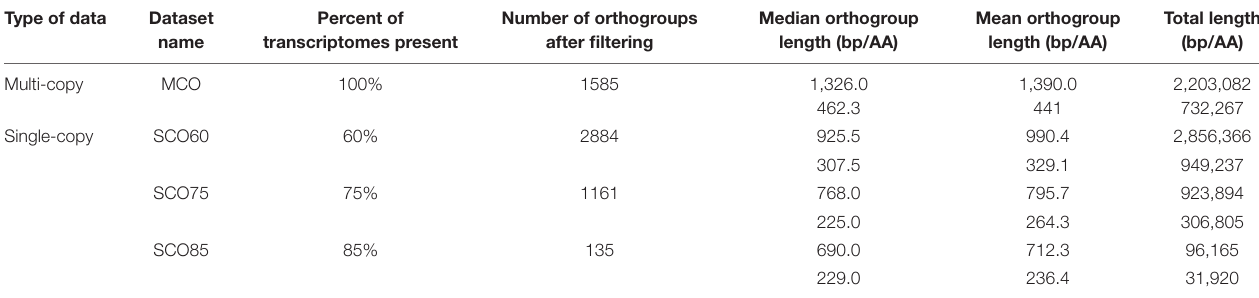
TABLE 2 | Datasets constructed in this study and corresponding